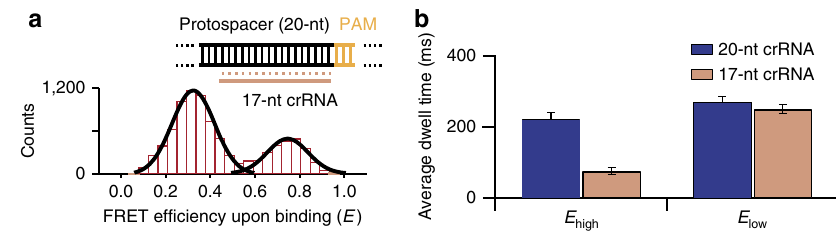
Figure 3 | Effects of crRNA complementarity on R-loop conformations. ( a ) A histogram of the FRET upon binding (we selected the molecules emitting Cy5 signal) to wild-type target DNA with 17-nt crRNA exhibits two peaks centred at 0.29 and 0.76, with Gaussian fits (black line). 17-nt crRNA is illustrated by pink line. ( b ) Comparison with each average dwell time of E high and E low from 20-nt or 17-nt crRNA (from dwell time distributions in Supplementary Figs 5 and 6; mean ± s.e.m., n